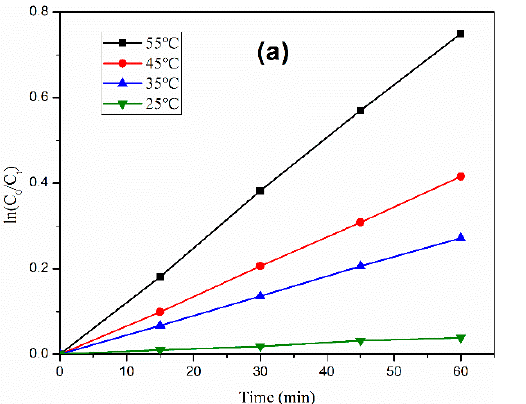
Figure 7. Quasi − first − order reaction kinetics of ciprofloxacin at different temperatures ( a ) and the apparent activation energy of ciprofloxacin’s chemical reaction in the US/E/PS ( b ).